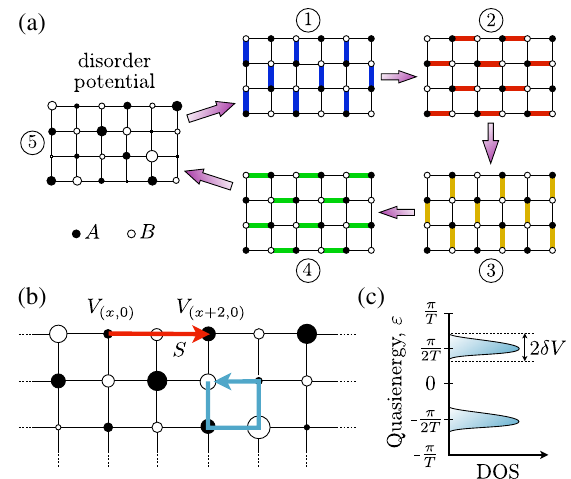
FIG. 2. Simple explicit model for achieving the anomalous Floquet-Anderson phase. (a) The Hamiltonian is piecewise constant, defined in five equal length segments of duration T= 5 . During steps 1 – 4, nearest-neighbor hopping is applied along the colored bonds as shown. The hopping strength J is chosen such that a particle hops between adjacent sites with probability one during each step. In the fifth step, all hopping is turned off and a random disorder potential is applied (the same potential is used for all subsequent driving cycles). (b) Over one driving period, a particle initialized on any site in the bulk returns precisely to its original position (blue arrow). Along the upper edge, a particle initialized on site ð x; 0 Þ of the A sublattice shifts two sites to the right (red straight arrow) and acquires a phase e − i ½ π = 2 þ V ð x þ 2 ; 0 Þ T= 5 (cid:2) . (c) With disorder, the quasienergy spectrum consists of two nonoverlapping bands of width 2 δ V , centered at ε ¼ (cid:3) π = 2 T